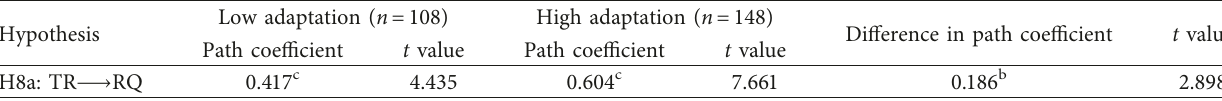
Table 8: PLS analysis of different levels of contractual